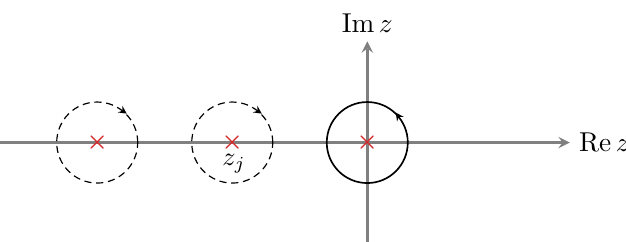
Figure 2. Schematic of the contour deformation used to derive (4.3). The solid contour centered around z = 0 , whose residue is the original wavefunction coefficient, ψ (0) , can be deformed into the dashed contour to write the wavefunction as a sum over the residues of the other poles of ψ ( z ) , located at z j